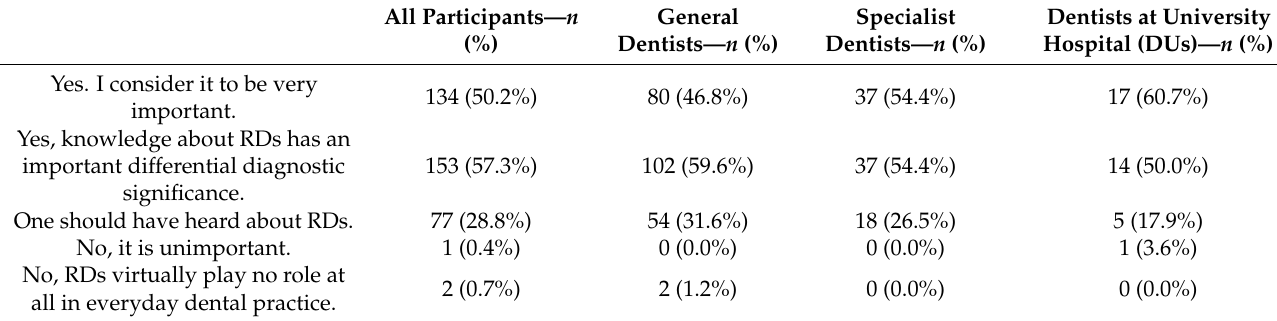
Table 4. Do you, as a dentist, consider it important to have knowledge about RDs that manifest orofacially?